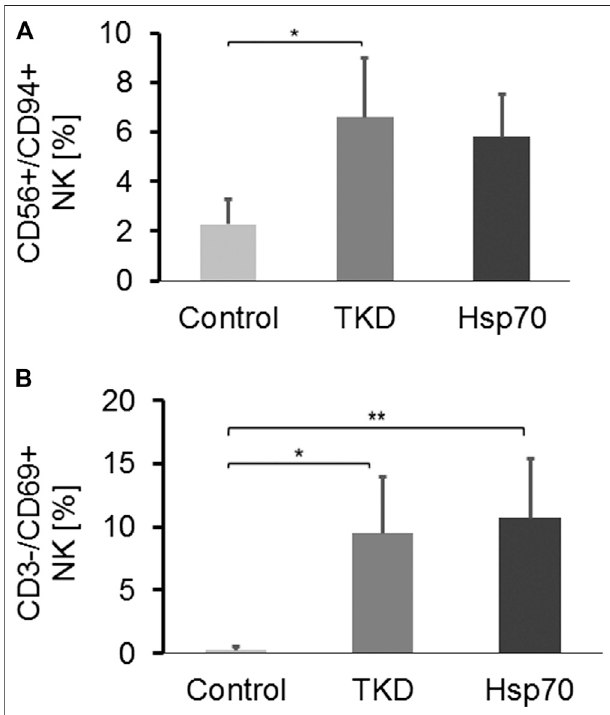
FIGURE 5 | (A) The proportion of CD3-/CD94+ NK cells in PBL of unstimulated healthy controls vs. Hsp70-peptide TKD/IL-2 or Hsp70/IL-2 stimulated PBL ( n (cid:1) 4) (Tukey; * p < 0.05, ** p < 0.01). (B) The proportion of CD3-/CD69+ NK cells in PBL of unstimulated healthy controls ( n (cid:1) 4)